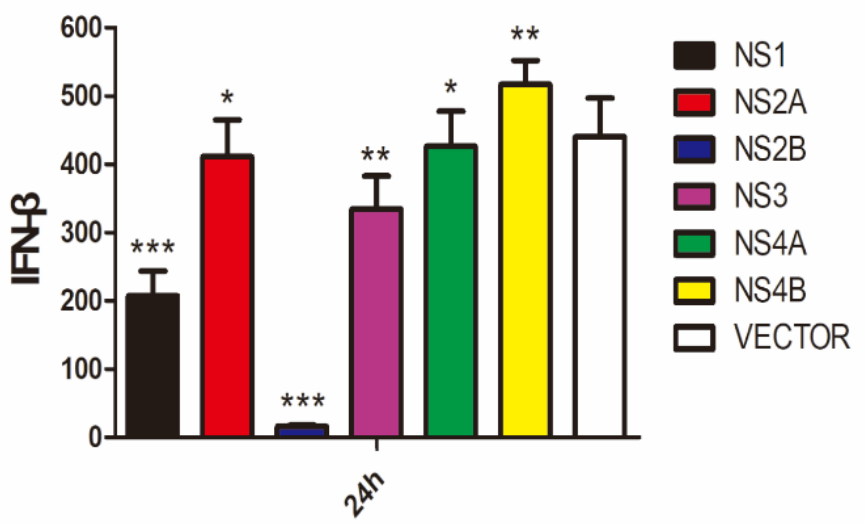
Figure 5. Inhibition of poly(I:C)-induced IFN- β expression by DTMUV NS2B. DF1 cells were trans- fected with plasmids expressing Myc-tagged DTMUV NS1, NS2A, NS2B, NS3, NS4A, or NS4B, re- spectively, and treated with 1μg/mL poly(I:C). Cells were harvested at 24 h post-transfection, and the protein expression levels of NS1, NS2A, NS2B, NS3, NS4A, and NS4B in poly(I:C)-treated cells were determined by Western blot with anti-Myc serum. IFN- β induction at the mRNA level from above samples was determined by RT-qPCR and presented. Error bar represents the standard error of three replicate experiments. T tests were performed by comparing the vector-transfected sample (white) to samples transfected with each of the viral gene. (ns, nonsignificant; * p < 0.05; ** p < 0.01; *** p < 0.001 ）